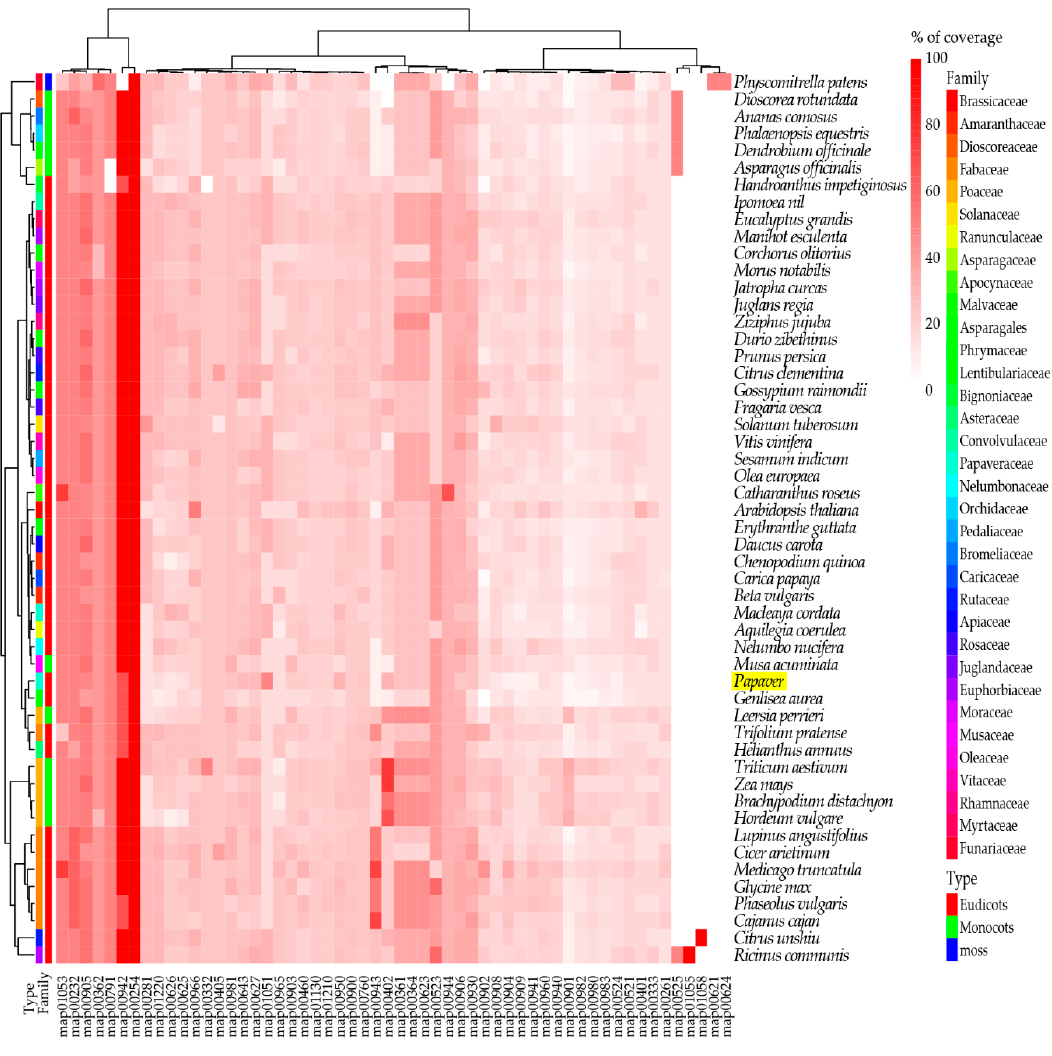
Figure 3. Overview of secondary metabolite biosynthesis pathways and its coverage. Here the transcripts were linked to the KEGG orthologs (KO), by assessing the sequence similarity between KOs and Papaver transcripts, which was obtained from the ortholog analysis. The coverage of each pathway was calculated and plotted into the percentage scale (0 to 100%). Here, the coverage was calculated by the formula (Coverage per each KEGG map = (Number of KOs present in transcriptome/Total number of KOs) × 100).